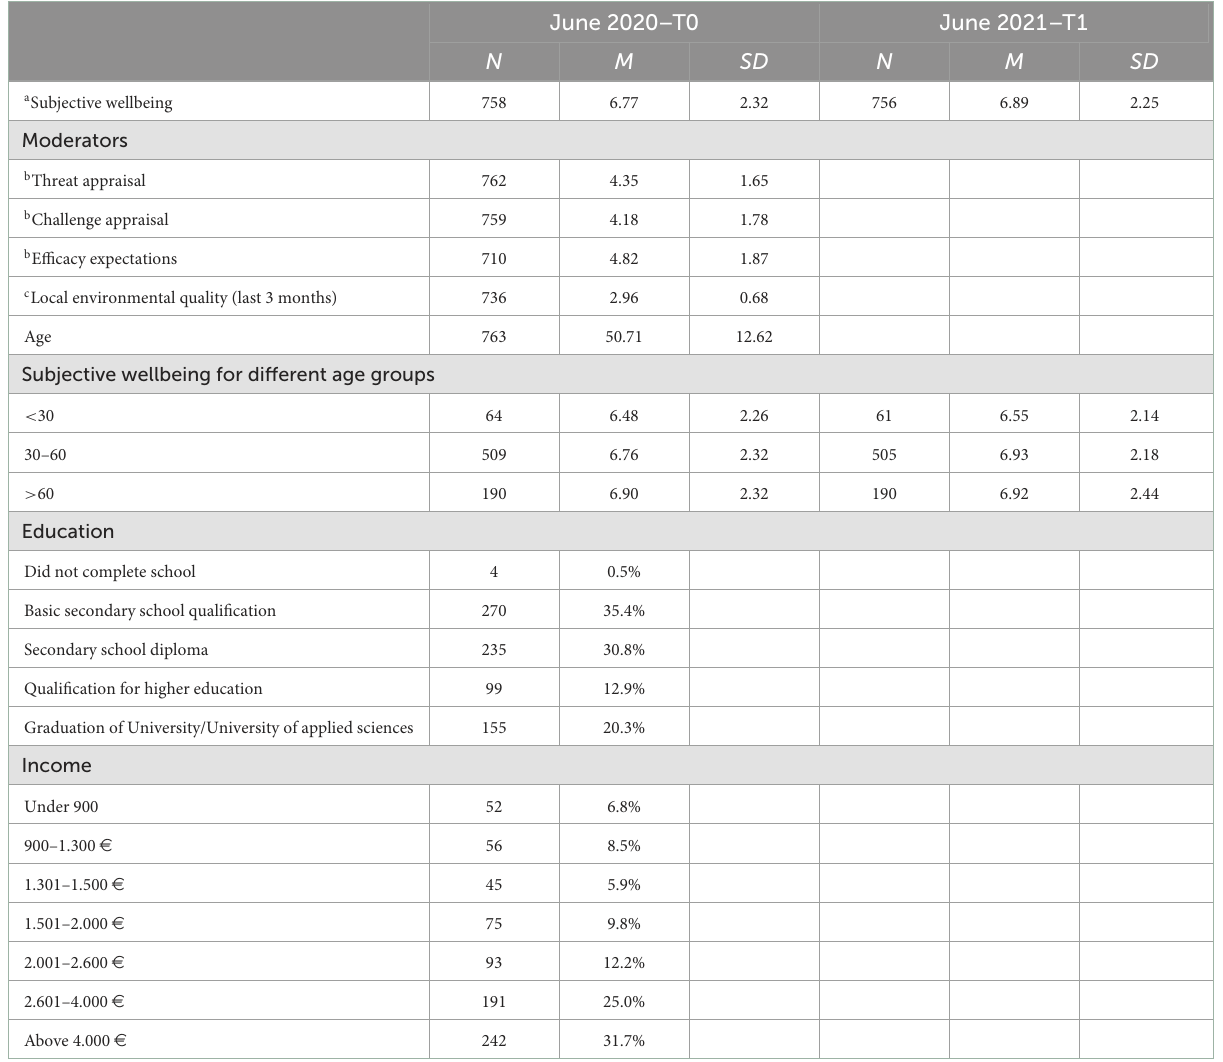
TABLE 1 Sociodemographic and descriptive